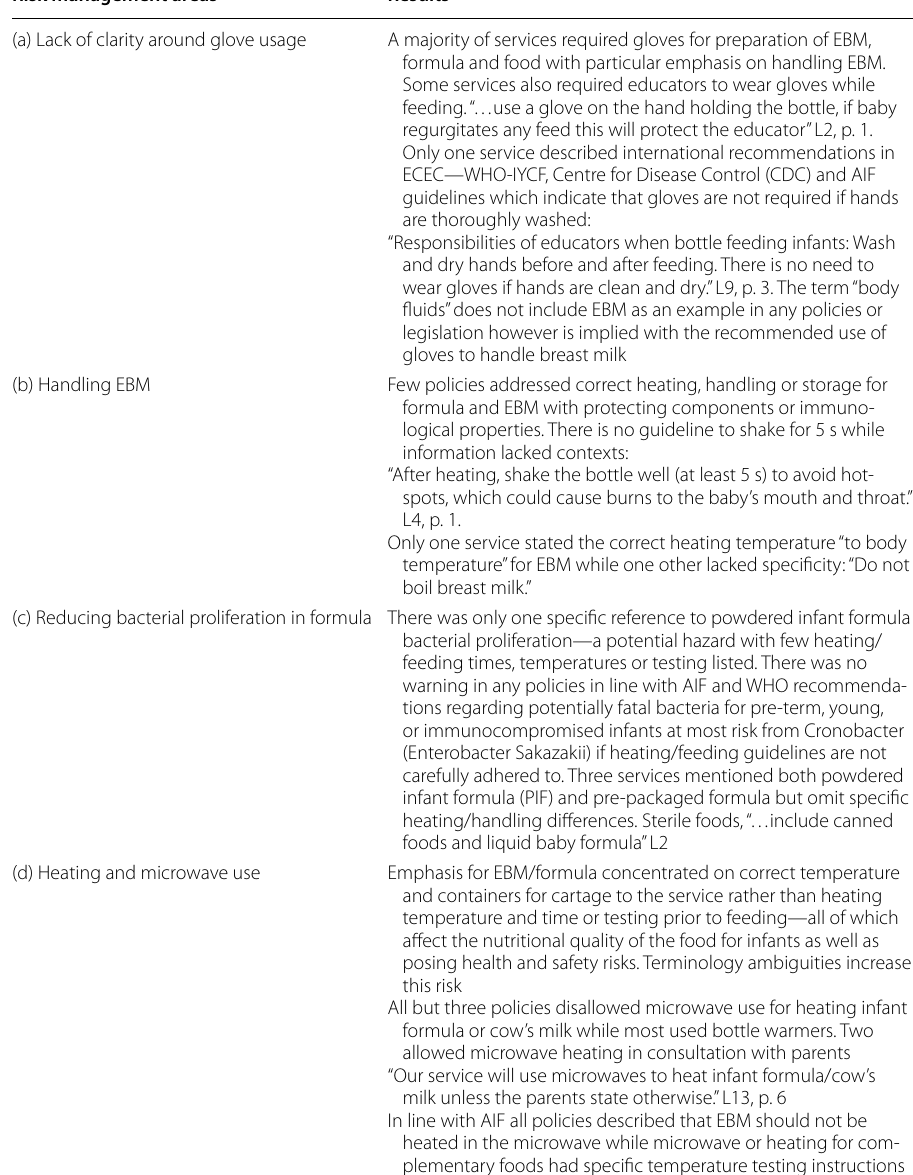
Table 6 risk management areas Risk management